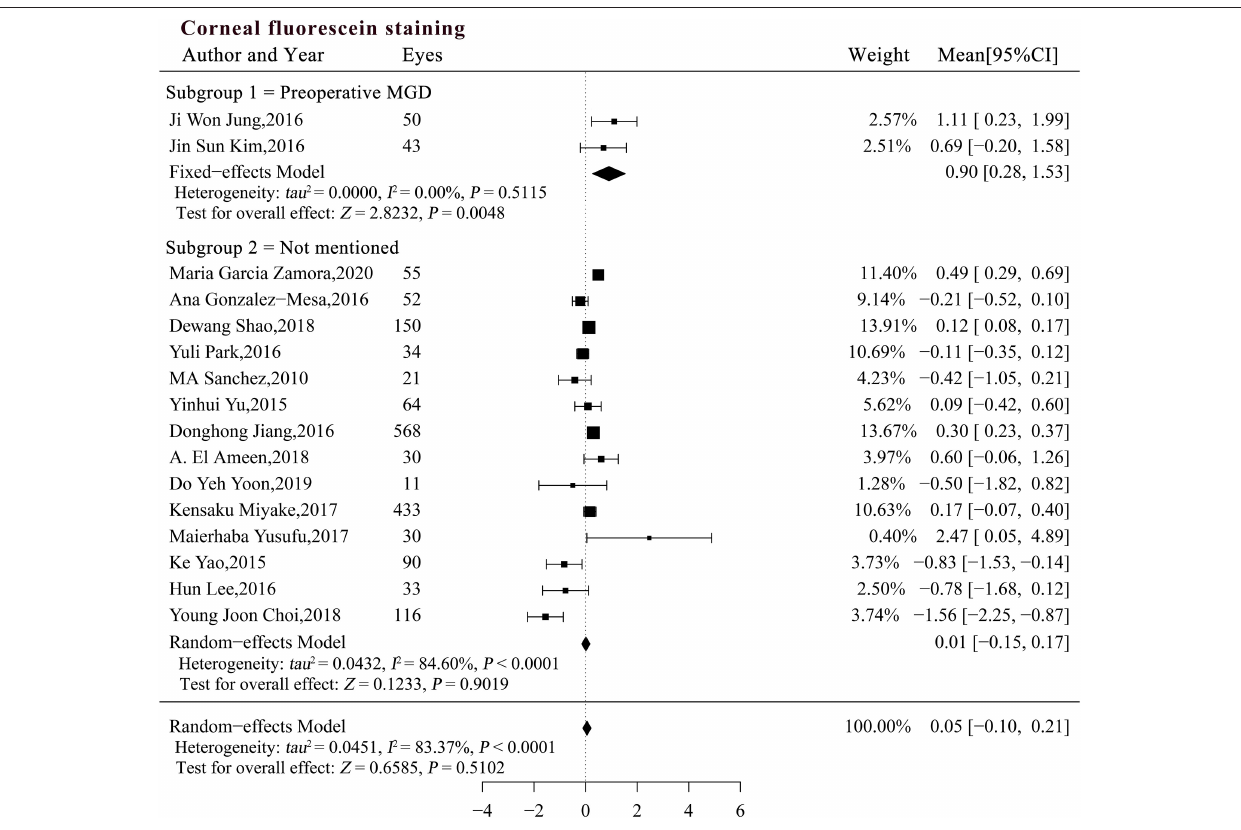
FIGURE 4 | Forest plots of change in corneal fluorescein staining after phacoemulsification cataract surgery. CI, confidence